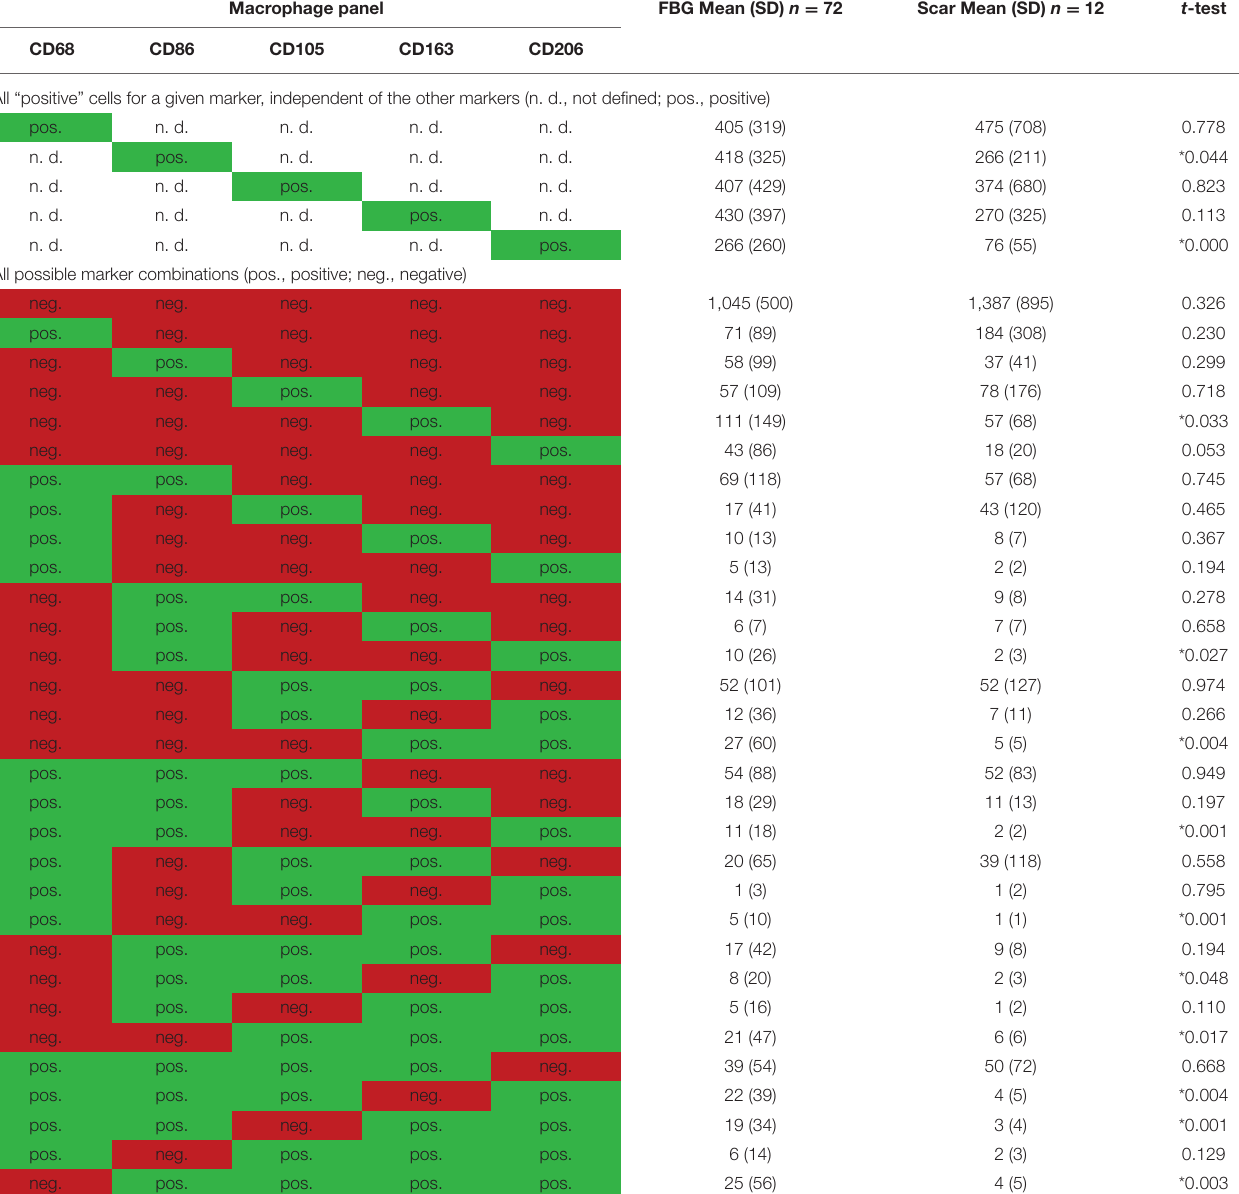
TABLE 3 | Comparison of cells located in the FBG and in the scar tissue by means of the macrophage panel. Macrophage